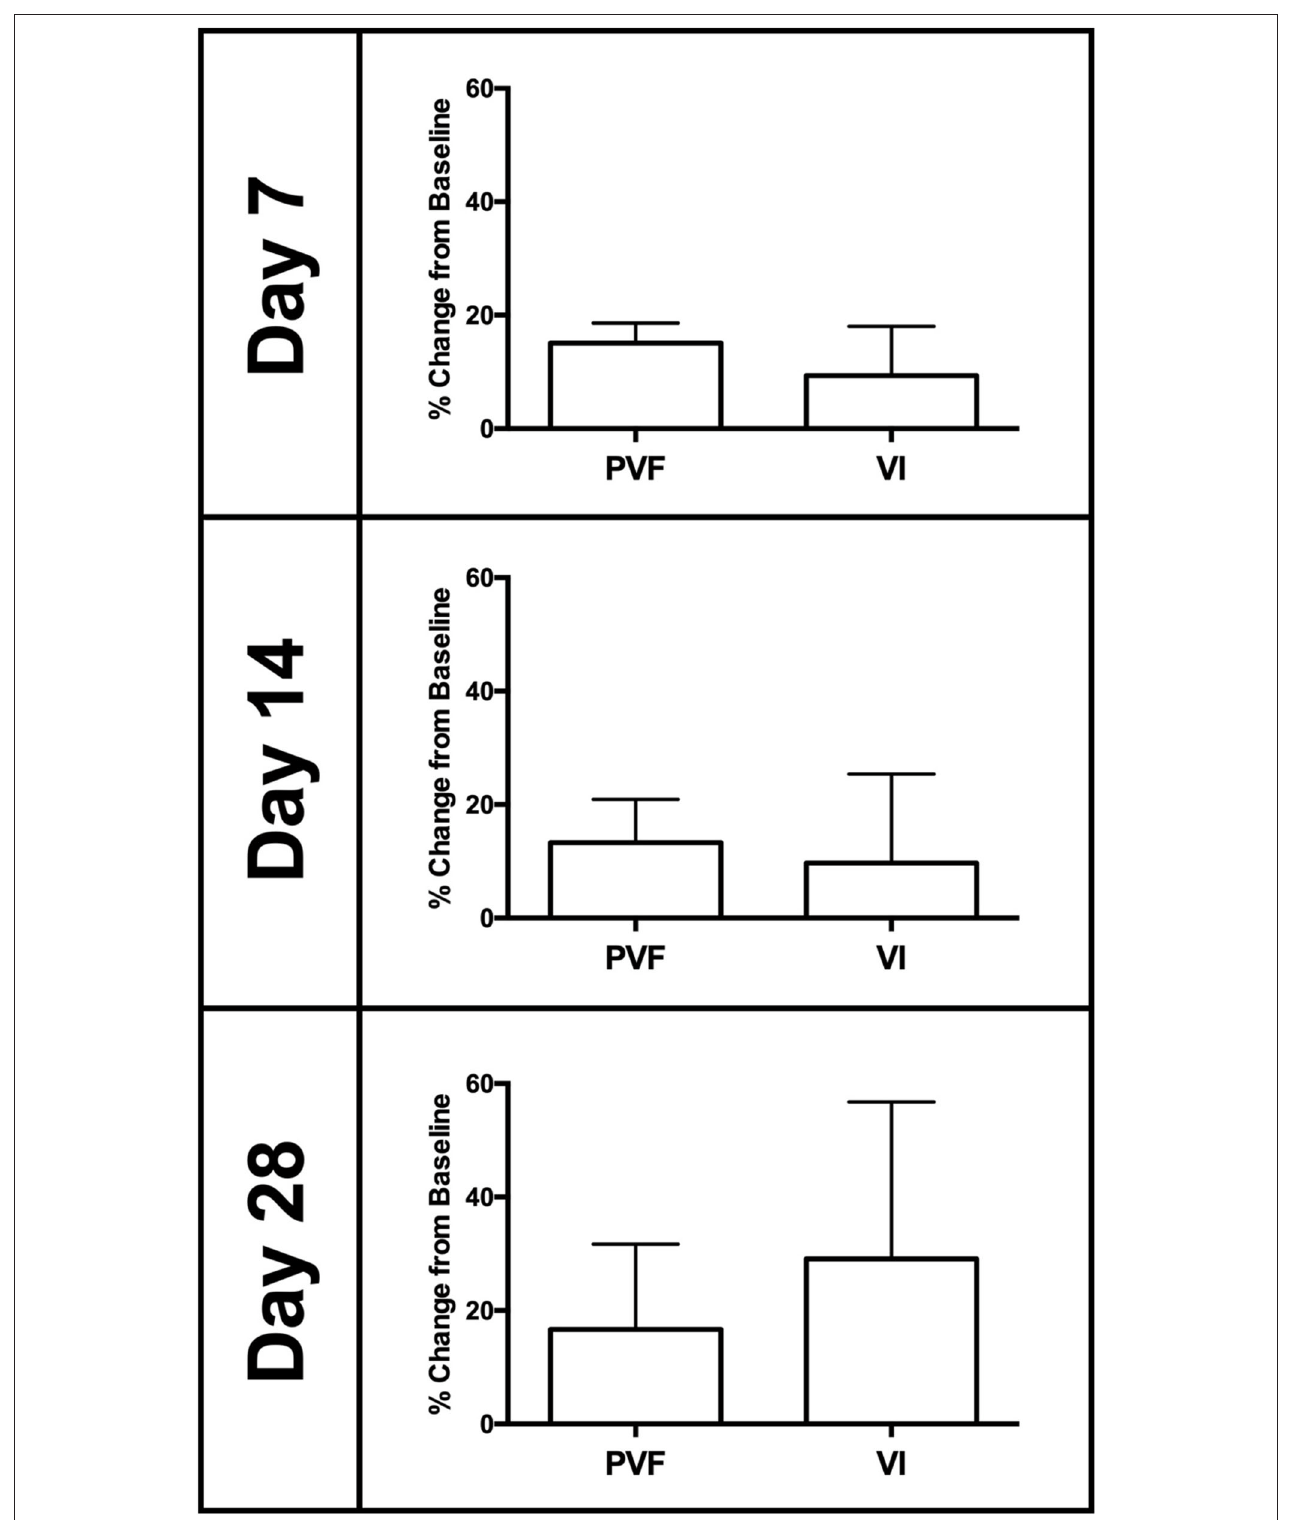
FIGURE 4 | Mean ( ± SD) ground reaction force (GRF) data (peak vertical force (PVF) and vertical impulse (VI)) presented as a percentage change from baseline (normalized as a percentage of body weight). Data represent the affected limb of dogs with non-surgical treatment (i.e., ZOL + RT). Overall, improvements in GRF measurements (PVF and VI) showed improved weight bearing in the affected limb as compared to baseline measurements, following therapy.